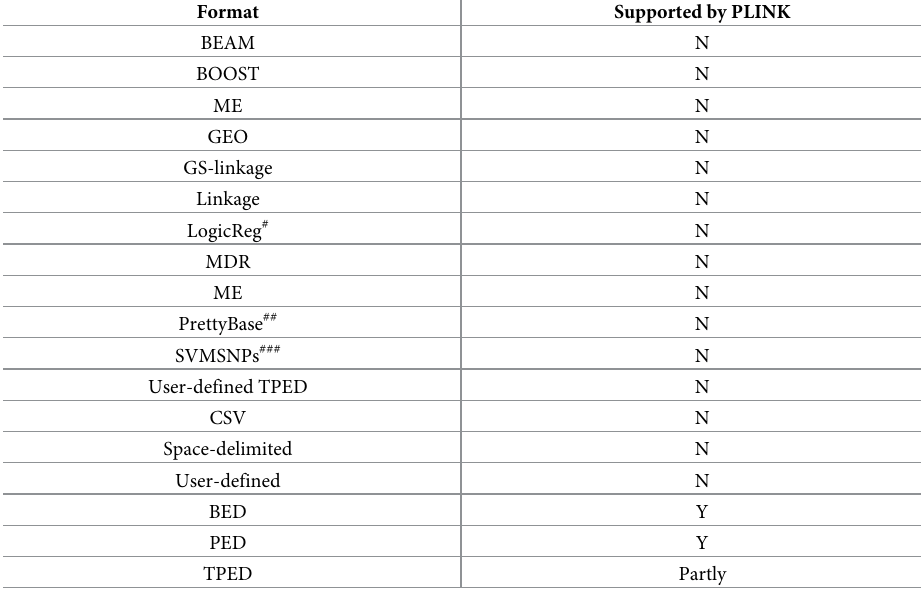
Table 1. Supported formats by coPLINK.